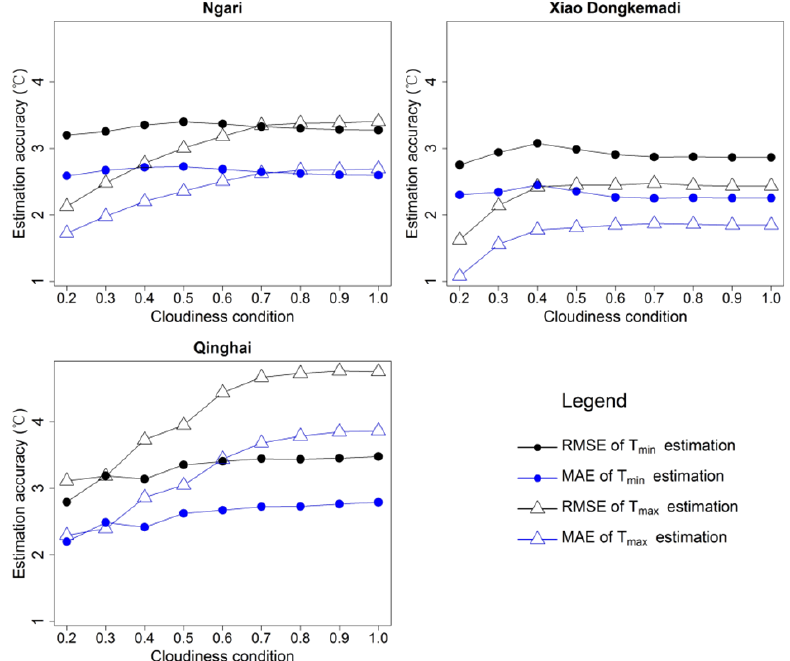
Figure 6. Accuracies (RMSE and MAE) of T max and T min estimations based on ground-measured LST under different cloudiness conditions across the three sites. The “cloudiness condition” is the constraining condition of the daily averaged cloudiness index (CI). For example, a cloudiness condition of 0.2 denotes a constraining daily mean of CI ≤ 0.2.